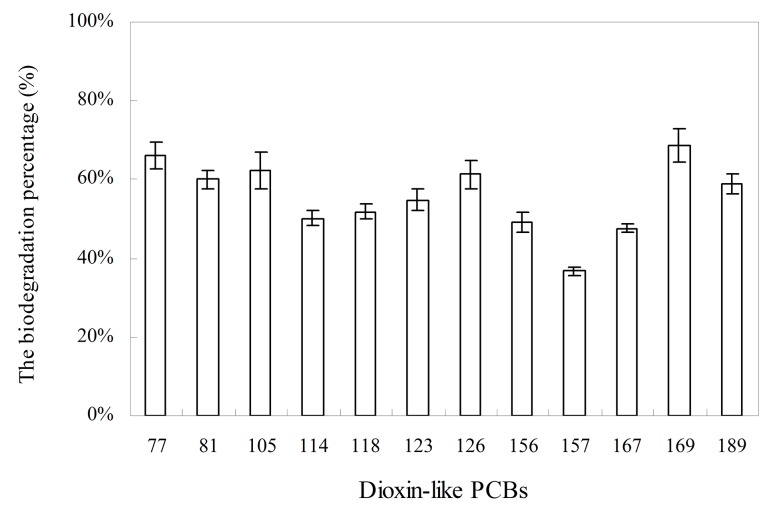
The biodegradation percentage of dioxin-like PCBs degraded by Anabaena PD-1 for 7 days.The total initial exposure concentration for dioxin-like PCBs is 2 mg/L. The result was presented as the mean values of quadruplicate experiments.